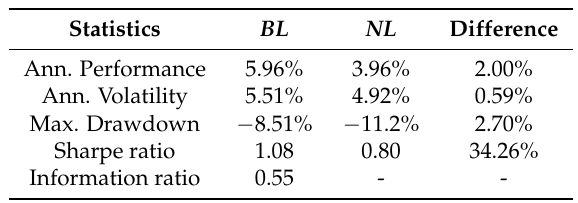
Table 3. Statistics for the BL and NL strategies. The Sharpe Ratio is calculated as the ratio between annualized performance and annualized volatility. In this case, the difference is given in relative terms. Data from January 2000 to June 2018.